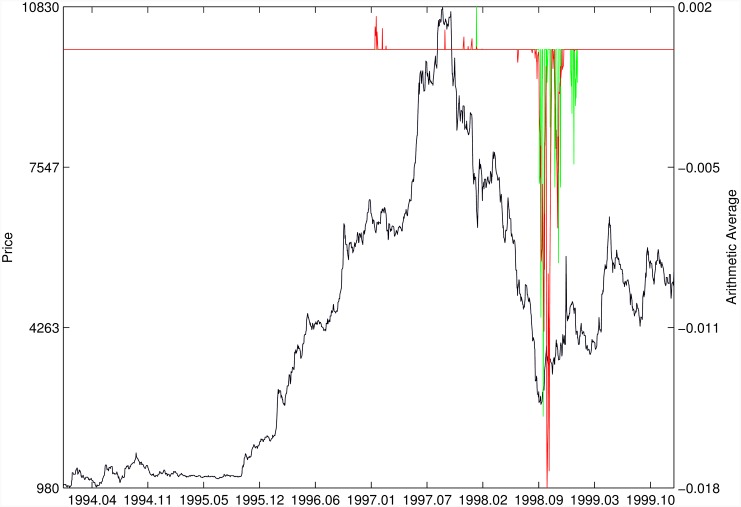
Venezuela 1997.Same as Fig 10.